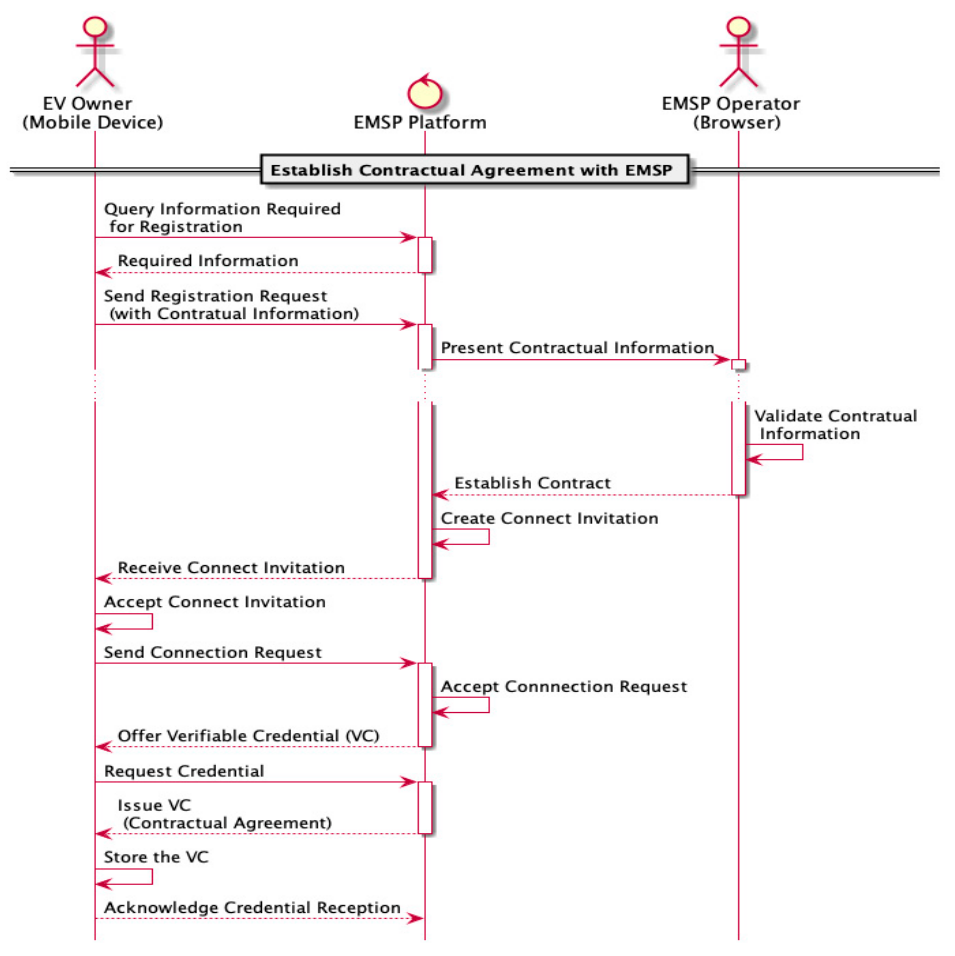
Figure 3. EV owner registration sequence diagram.